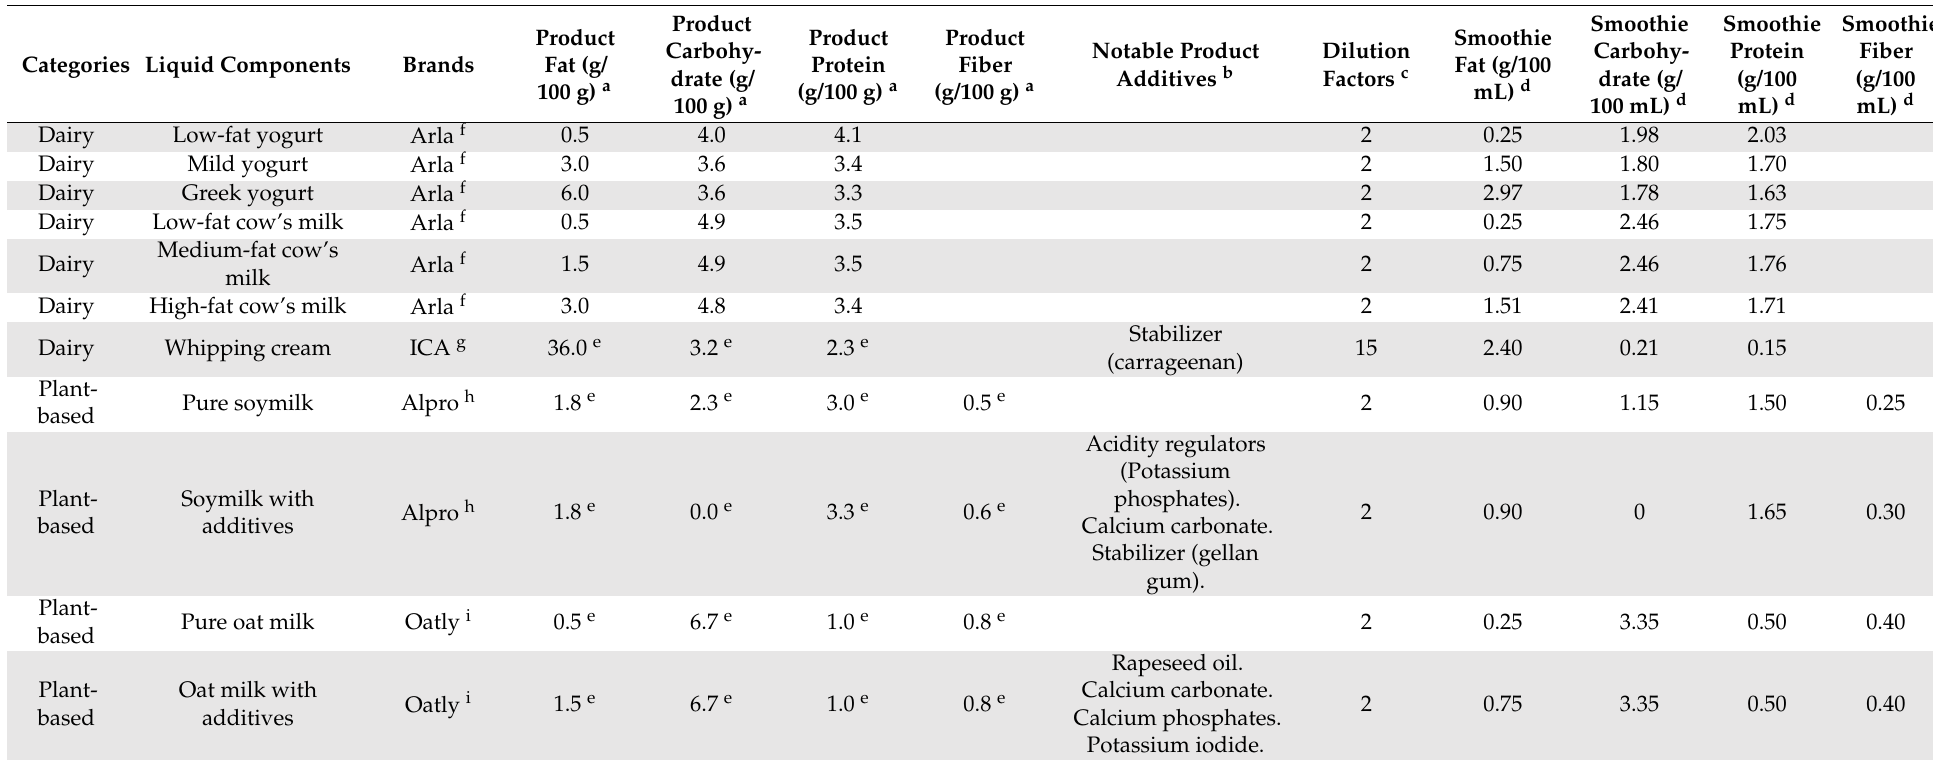
Table 1. Macronutrient and additive content of liquid components as well as macronutrient content in the corresponding